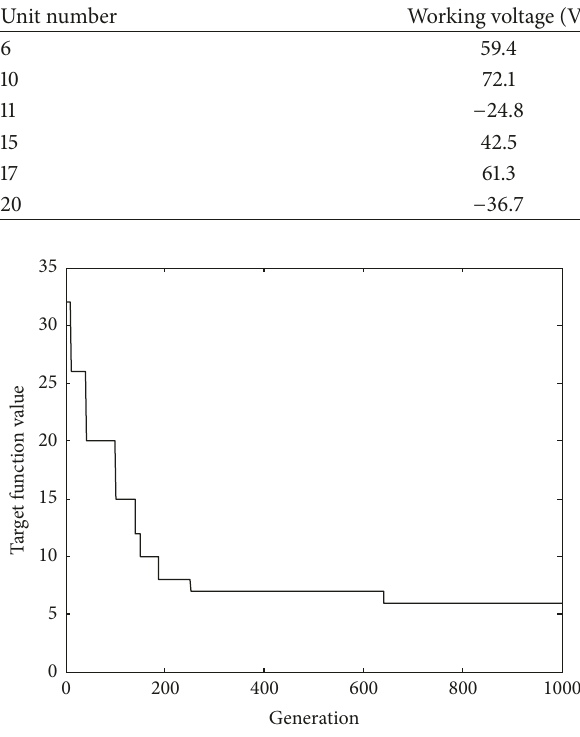
Figure 5: Variation of target function value.